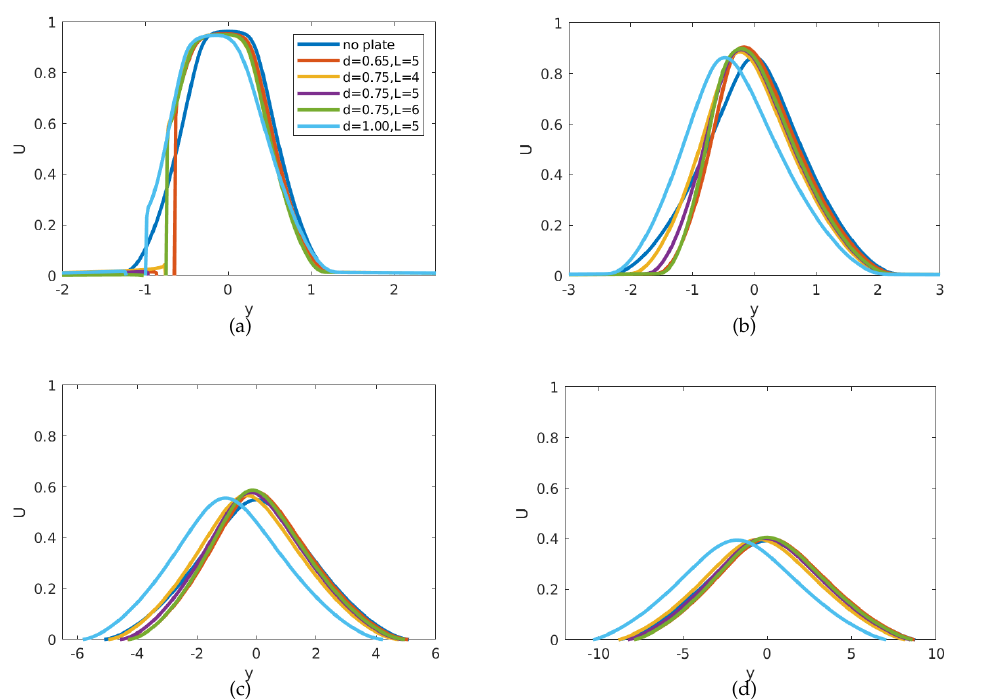
Figure 5. Streamwise velocity profiles along vertical direction, for different configurations: ( a ) x = 4 D j ; ( b ) x = 10 D j ; ( c ) x = 25 D j ; ( d ) x = 45 D j